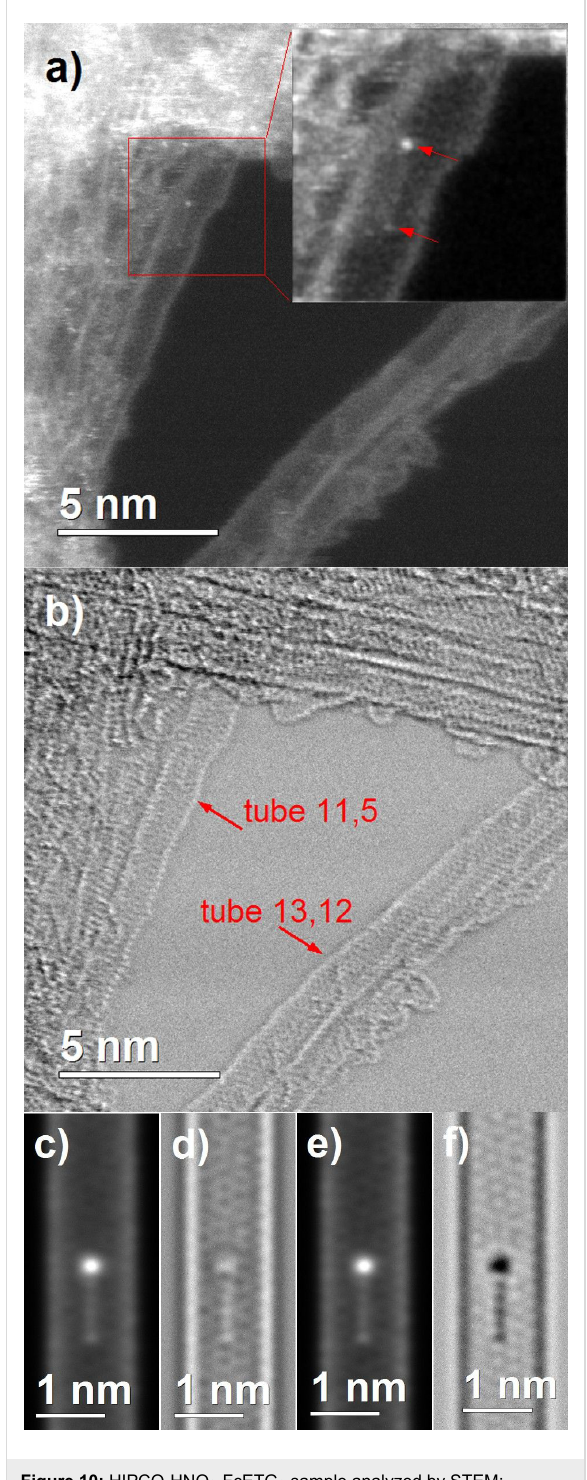
Figure 10: HIPCO-HNO 3 -FcETG 2 sample analyzed by STEM: a) HAADF image. The inset focuses on the FcETG molecule, the top arrow points to the ferrocene and the bottom arrow to the ester link. b) BF image simultaneously recorded for chiral index assignment. c–f) Simulated images of HAADF (c and e) and BF (d and f) of a 11,6 SWCNT grafted with a FcETG 2 molecule for over-focus of 1.7 nm (c and d) and under-focus of − 6.3